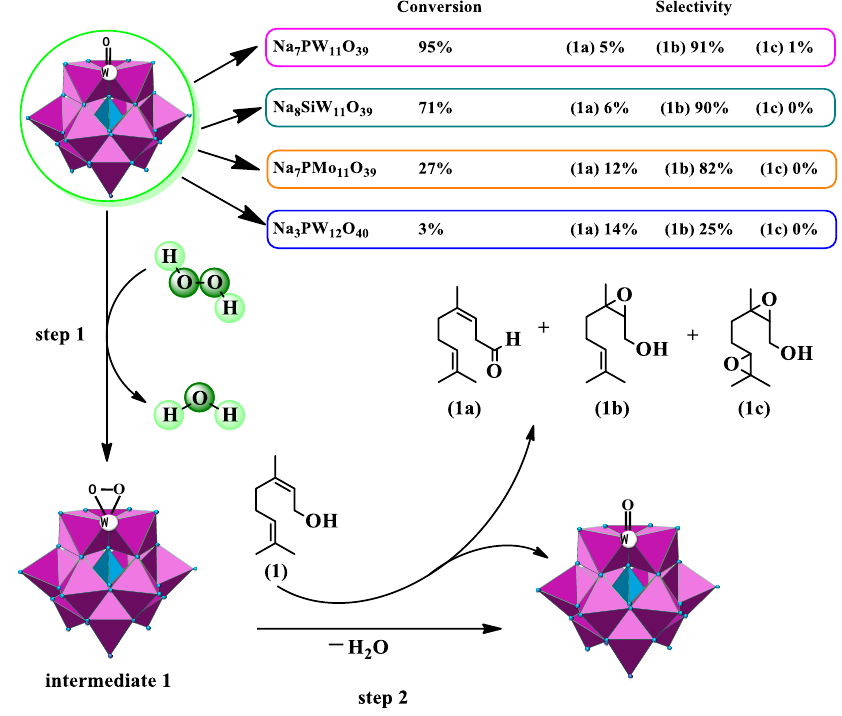
Figure 14. Impact of heteropolyanion on the efficiency of Keggin HPA sodium salts, main oxidation products of nerol a probable reaction pathway (adapted from ref. [26]).